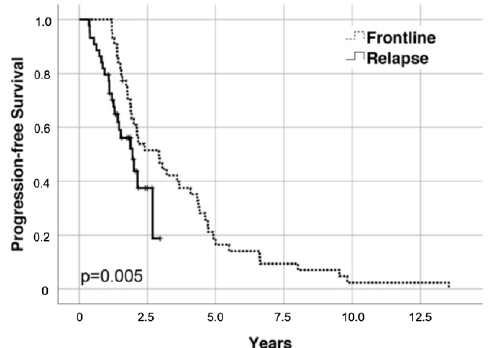
Figure 2. Kaplan – Meier plot of progression-free survival (PFS) from frontline and salvage ASCT, Figure 2. Kaplan–Meier plot of progression-free survival (PFS) from frontline and salvage ASCT, respectively. respectively.